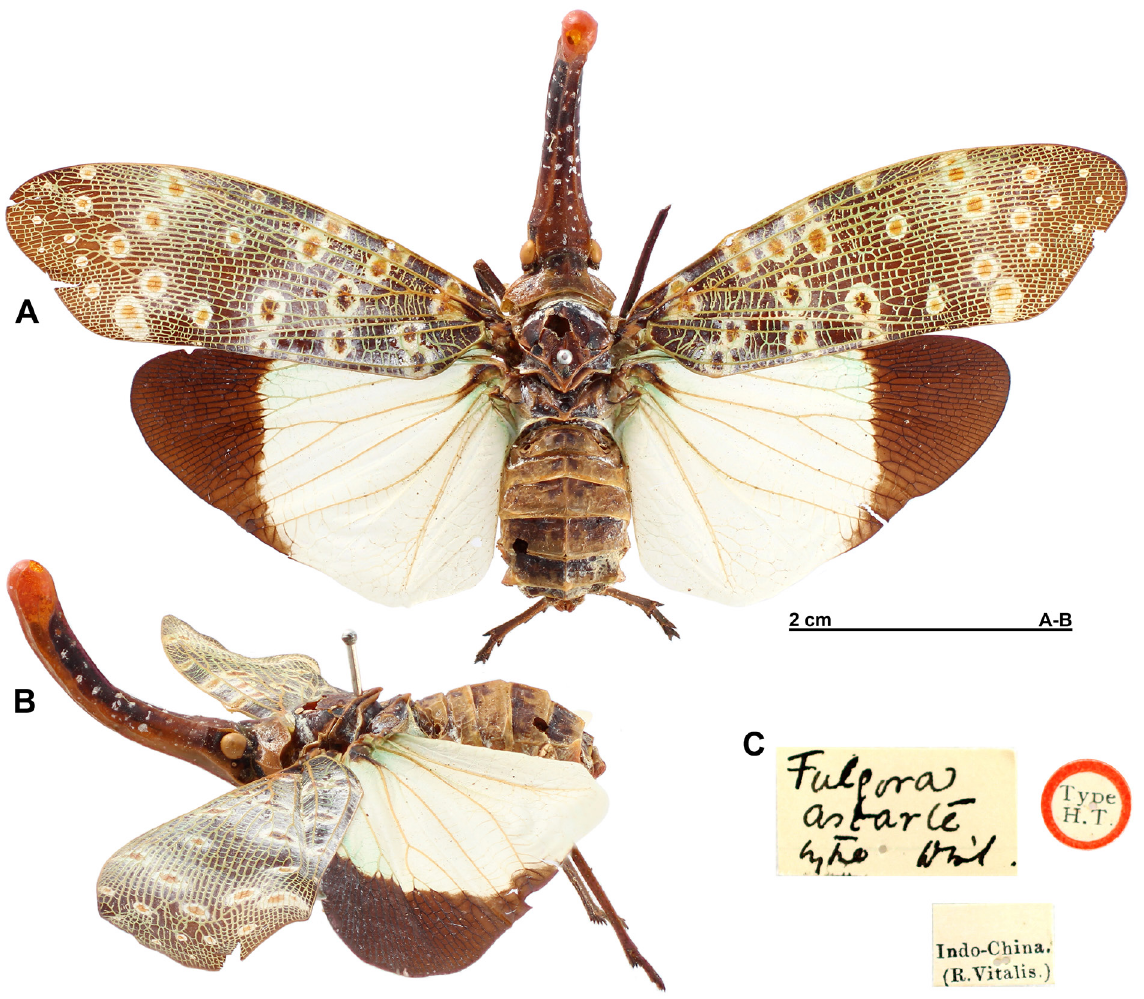
Fig. 7. Pyrops astarte (Distant, 1914), holotype ♀ (BMNH). A . Habitus, dorsal view. B . Habitus, lateral view. C .